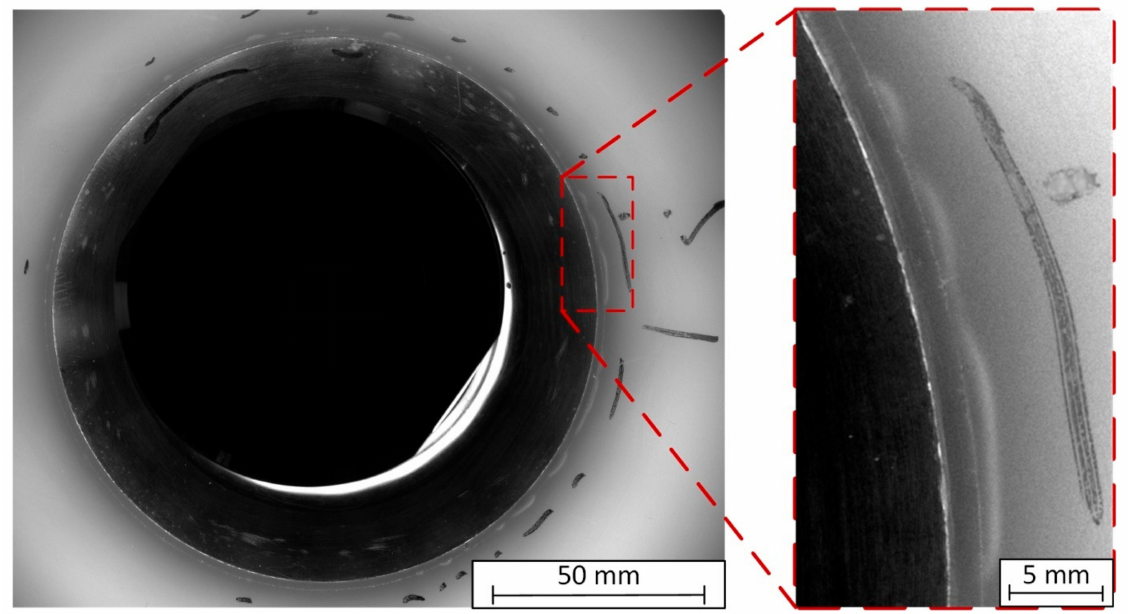
Figure 10. View of a liner’s inlet with air chain located near the